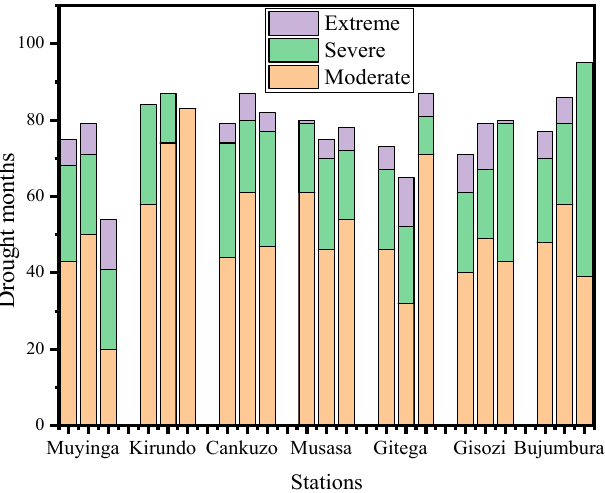
Figure 8. The number of drought events detected during the study period for each meteorological station.